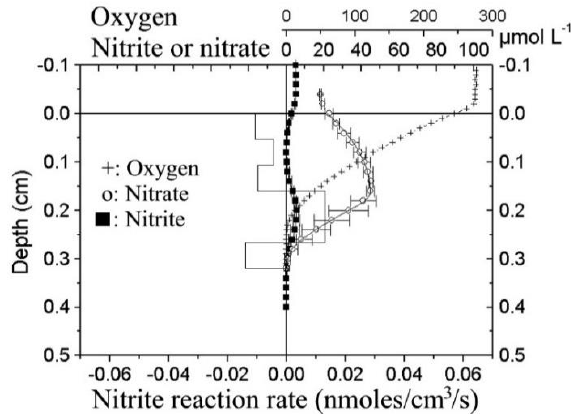
Figure 4. Microprofiles of O 2 , NO x − , and NO 2 − in an estuarine sediment (Randers Fjord). The NO x − and NO 2 − profiles shown are averages of each 3 profiles with standard deviation indicated. Also shown are rates of NO 2 − transformation obtained by diffusion-reaction modelling of the NO 2 − profile. (Data was obtained from the laboratory of the presented authors).